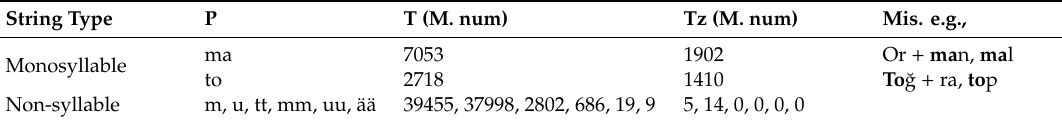
Table 10. T and Tz monosyllabic and non-syllable string search